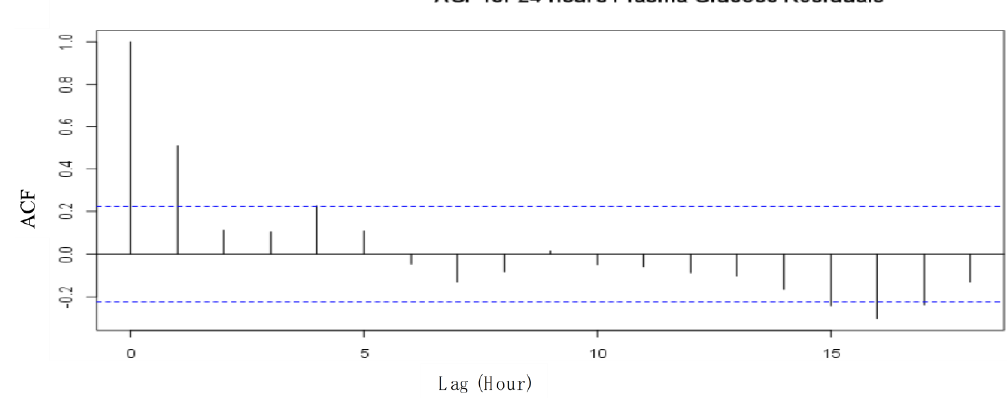
Figure 3. ACF for first 24 hours’ plasma glucose residuals from the SDE model.